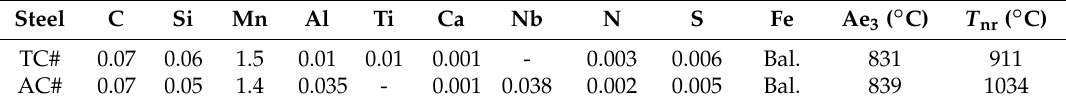
Table 1. Chemical compositions (wt %) and critical temperatures of experimental